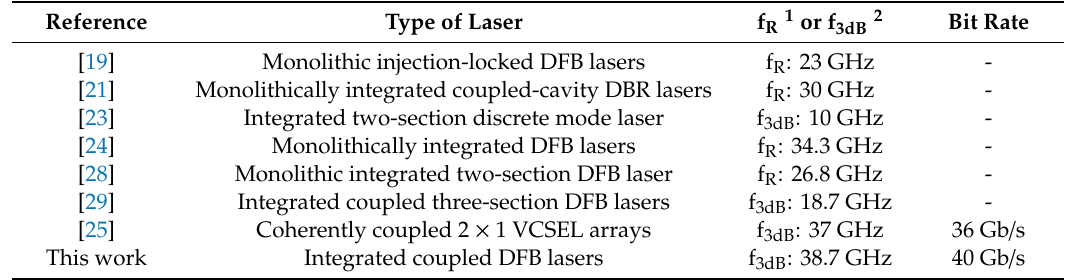
Table 1. Representative modulation performances of di ff erent integrated mutually coupled (IMC) lasers. Reference Type of Laser f R 1 or f 3dB 2 Bit Rate [19] Monolithic injection-locked DFB lasers f R : 23 GHz - [21] Monolithically integrated coupled-cavity DBR lasers f R : 30 GHz - [23] Integrated two-section discrete mode laser f 3dB : 10 GHz - [24] Monolithically integrated DFB lasers f R : 34.3 GHz - [28] Monolithic integrated two-section DFB laser f R : 26.8 GHz - [29] Integrated coupled three-section DFB lasers f 3dB : 18.7 GHz - [25] Coherently coupled 2 × 1 VCSEL arrays f 3dB : 37 GHz 36 Gb / s This work Integrated coupled DFB lasers f 3dB : 38.7 GHz 40 Gb /